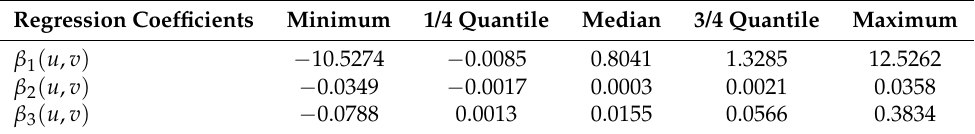
Table 3. Regression coefficients estimation with bandwidth matrix H